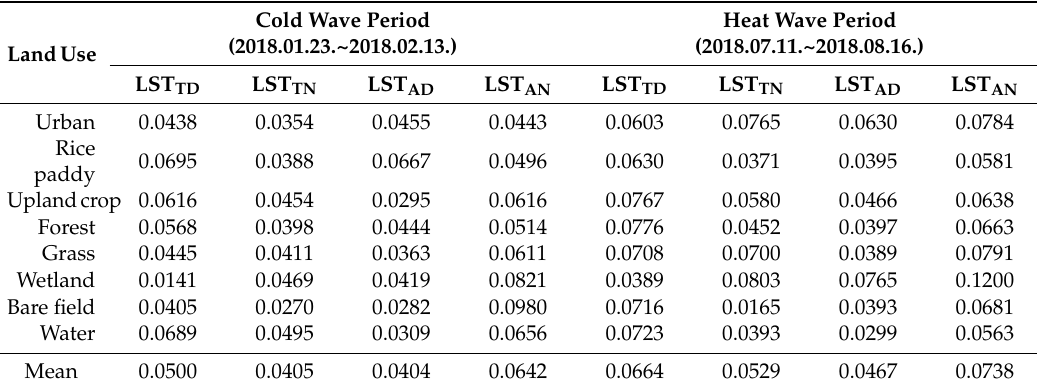
Table 4. Variable importance (root mean squared error di ff erence between TensorFlow-LSTM model results using normal and randomly permuted samples) of the 4 LST variables used to predict SAT during the cold wave period and heat wave period considering land use